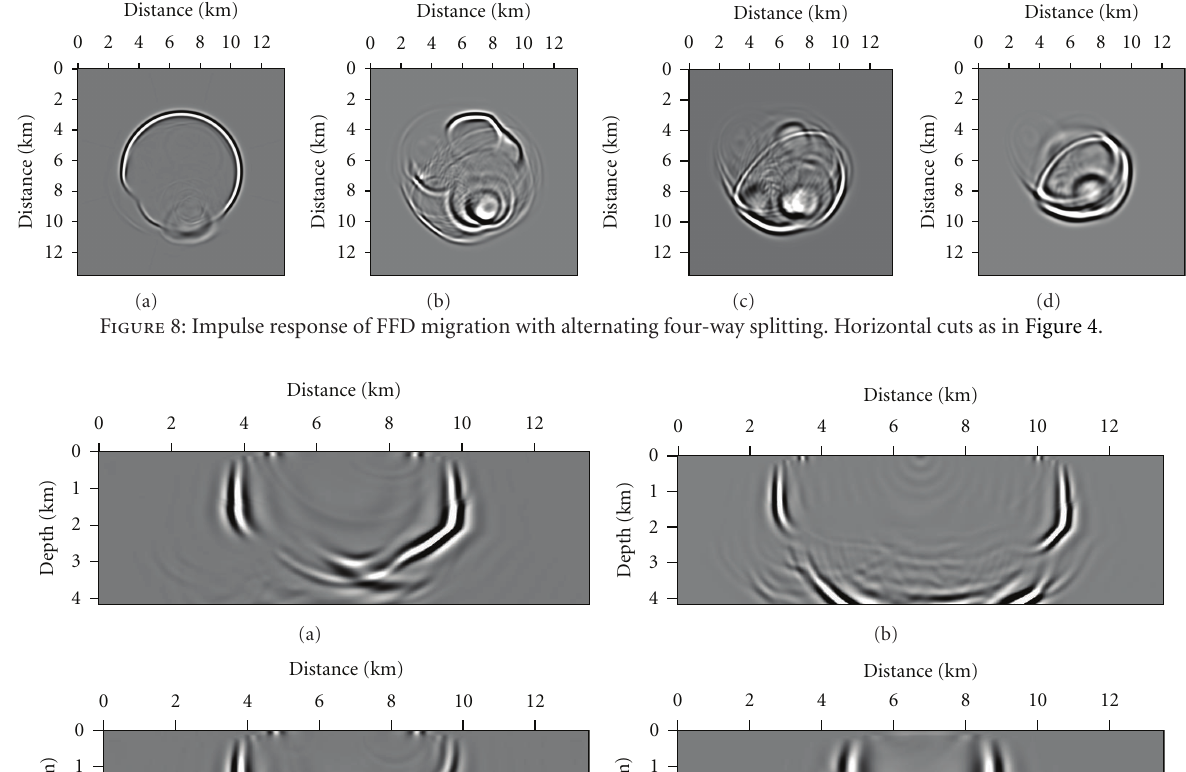
the x - z plane at y = 4 . 14 km and y = 10 . 22 km, as well as horizontal cuts at depths z = 1 . 7 m, z = 2 . 9 km, z = 3 . 5